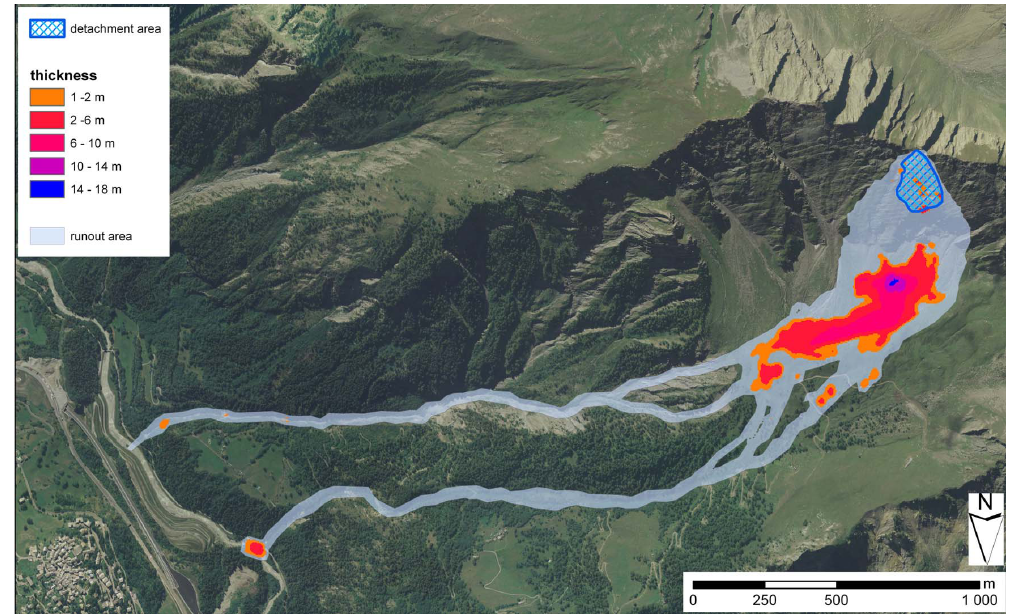
Fig. 14. Extension of the runout path and thicknesses of the accumulation computed by DAN3D considering a two-phase event. Compare with observed runout path on Fig.